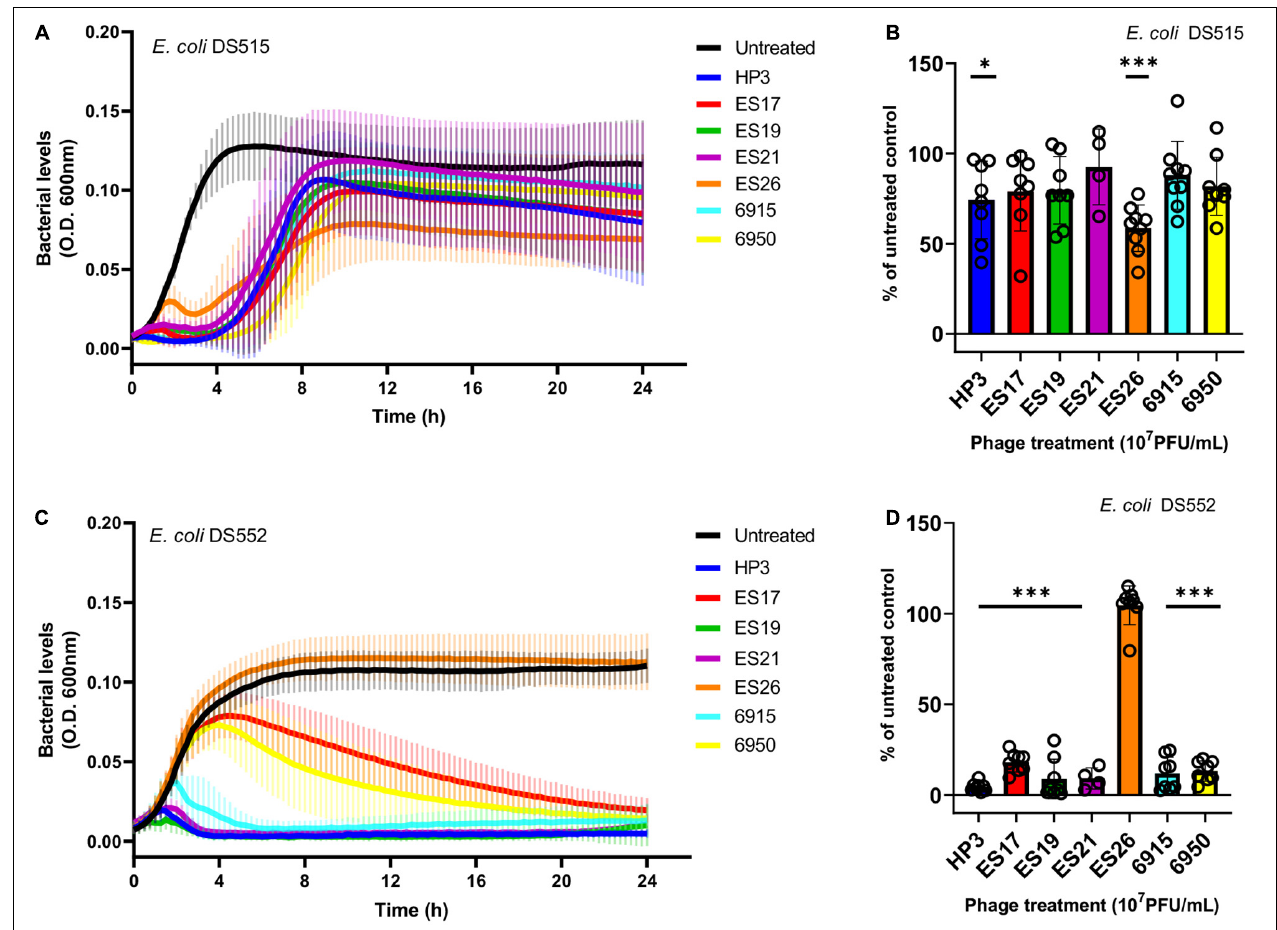
FIGURE 3 | The activity of anti-biofilm phage against E. coli planktonic cells in human urine. Bacterial growth was assessed for 24 h in the presence or absence of phage (10 7 PFU/mL). Bacterial growth was determined by OD 600 over time and as a percentage of the untreated control at 24 h, respectively, for E. coli DS515